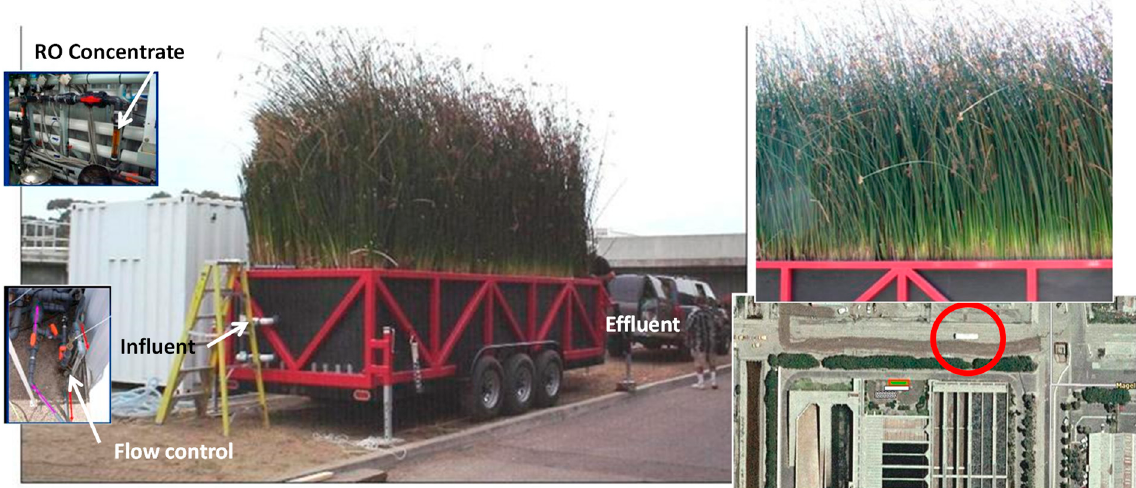
Figure 7. The MES wetland system for Pilot Study 2. The white trailer on the left is the AWPF pilot system and the wetland trailer is equipped with a solar cell to operate the pump used for water circulation. The right top photo shows lively bulrush plants after the 9-month-long pilot study with intense ROC pollution and the bottom photo shows the pilot study layout plan at the AWPF. The red circle shows the pilot plant at the AWPF.